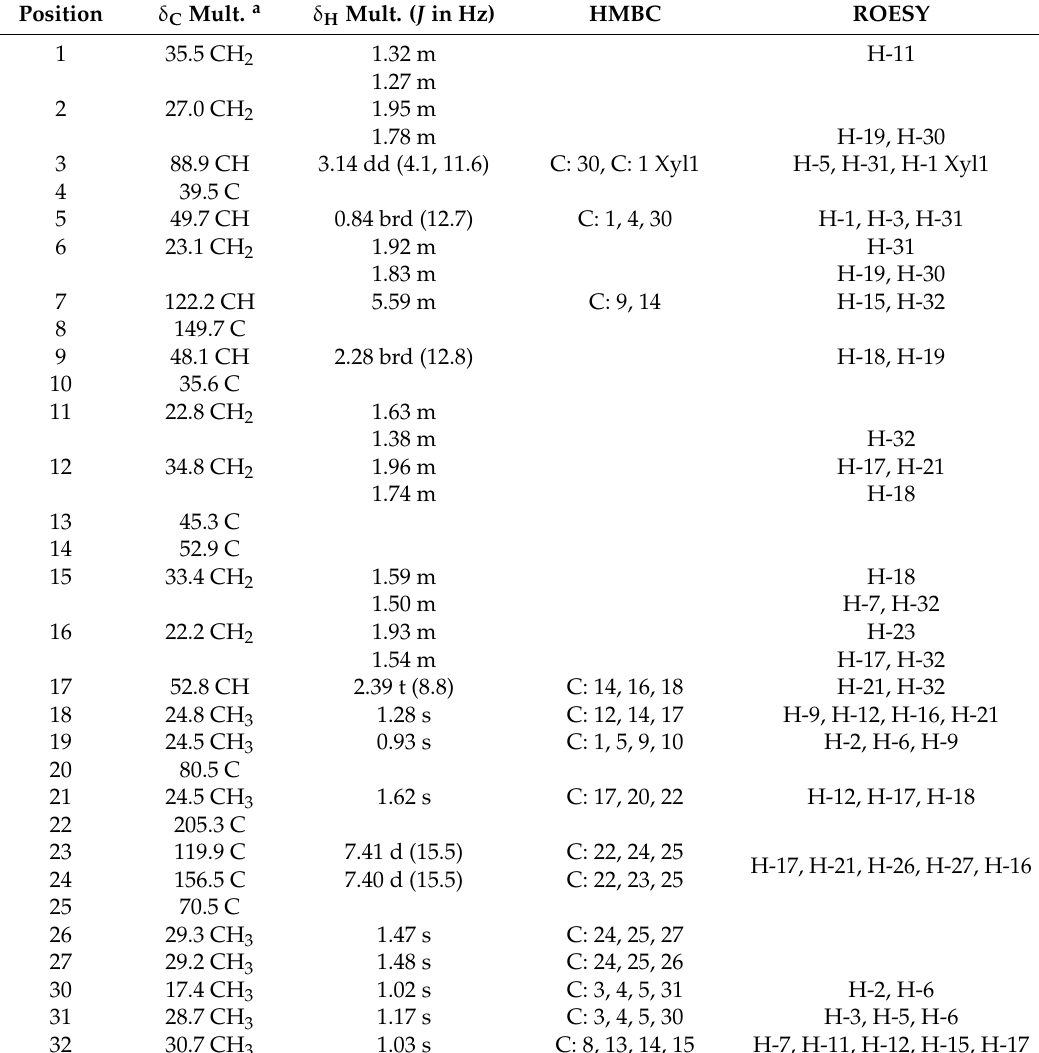
Table 4. NMR spectrosopic data (700 MHz, C 5 D 5 N/D 2 O (4/1 v / v )) of the aglycone moiety of fallaxoside D 6 ( 3